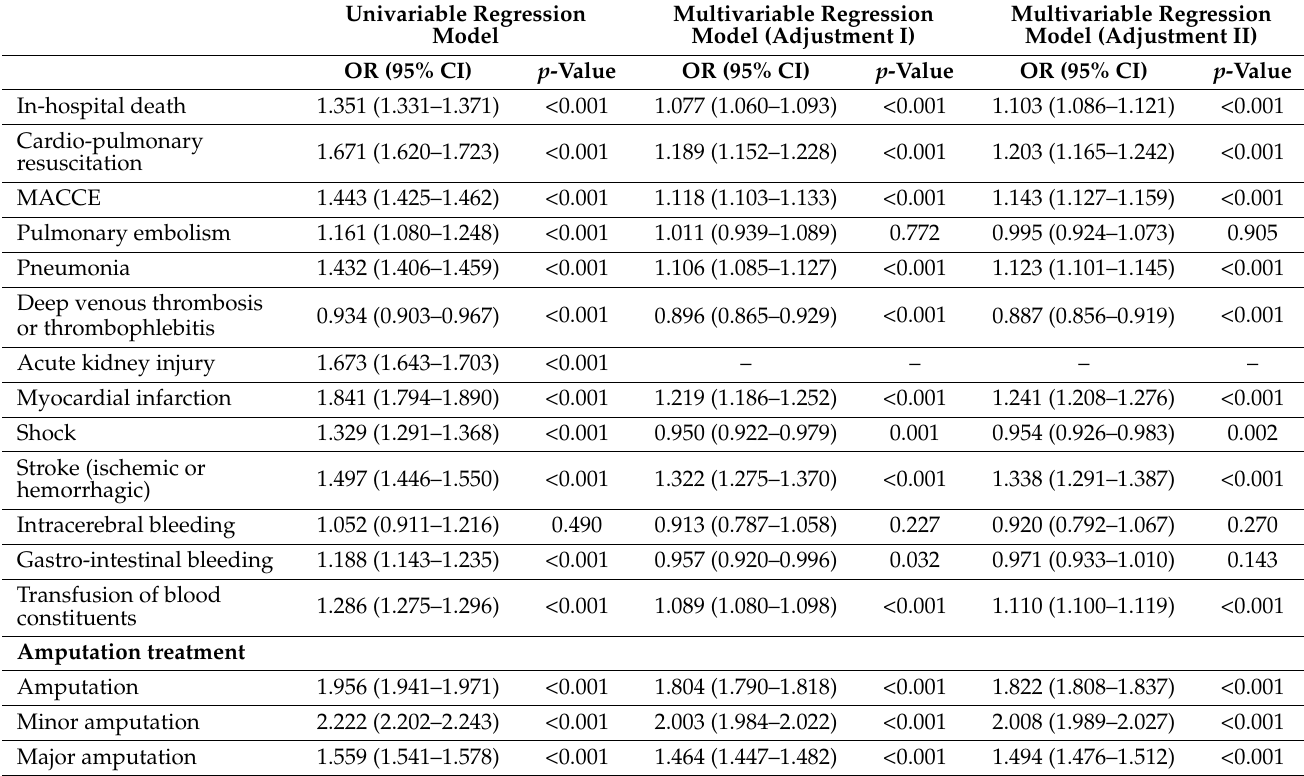
Table 2. Impact of diabetes mellitus on the different adverse in-hospital events in PAD patients (univariable and multivari- able logistic regression models).